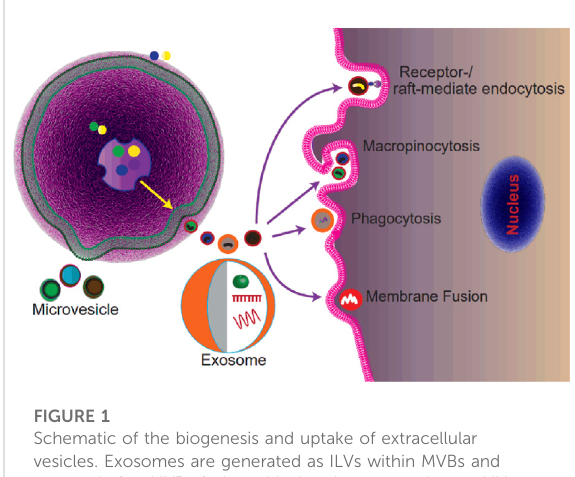
FIGURE 1 Schematic of the biogenesis and uptake of extracellular vesicles. Exosomes are generated as ILVs within MVBs and secreted after MVBs fusing with the plasma membrane. MVs are generated by the outward budding of the plasma membrane. EVs are internalized by recipient cells via micropinocytosis, or phagocytosis, or receptor-/lipid raft-mediated endocytosis, or membrane